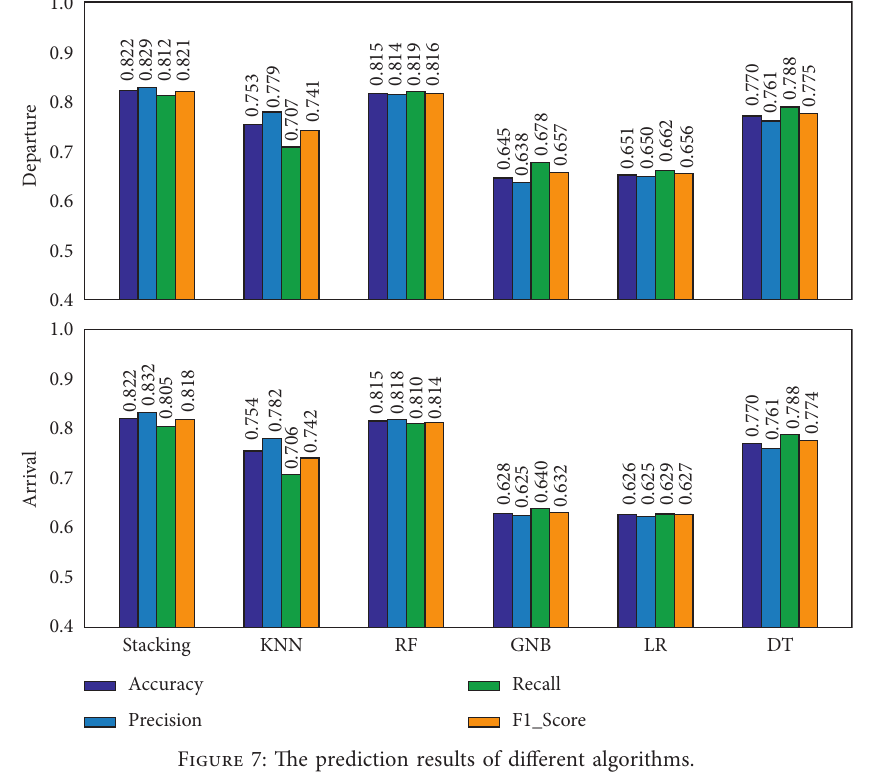
Figure 7: The prediction results of different